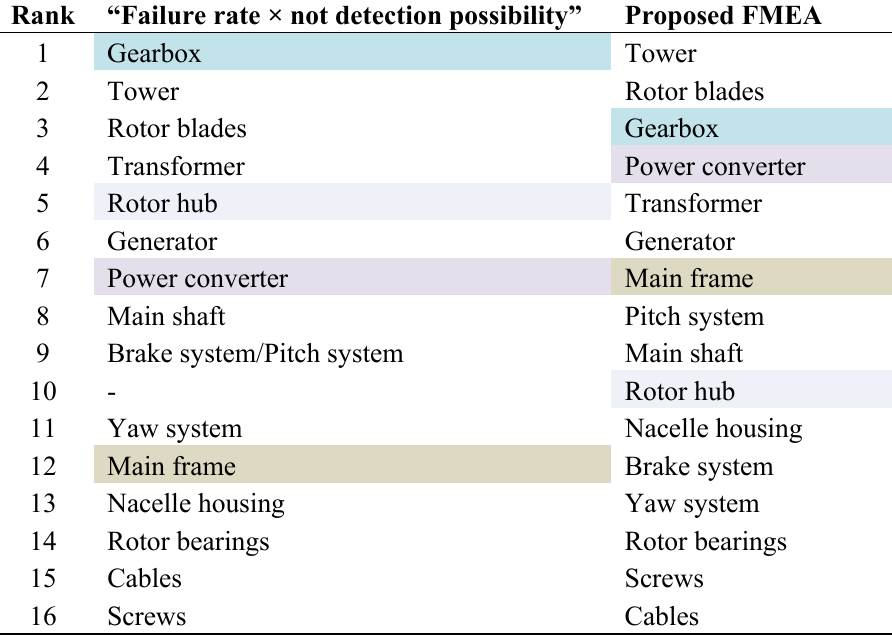
Table 11. Ranking comparisons between “ λ D × ” and